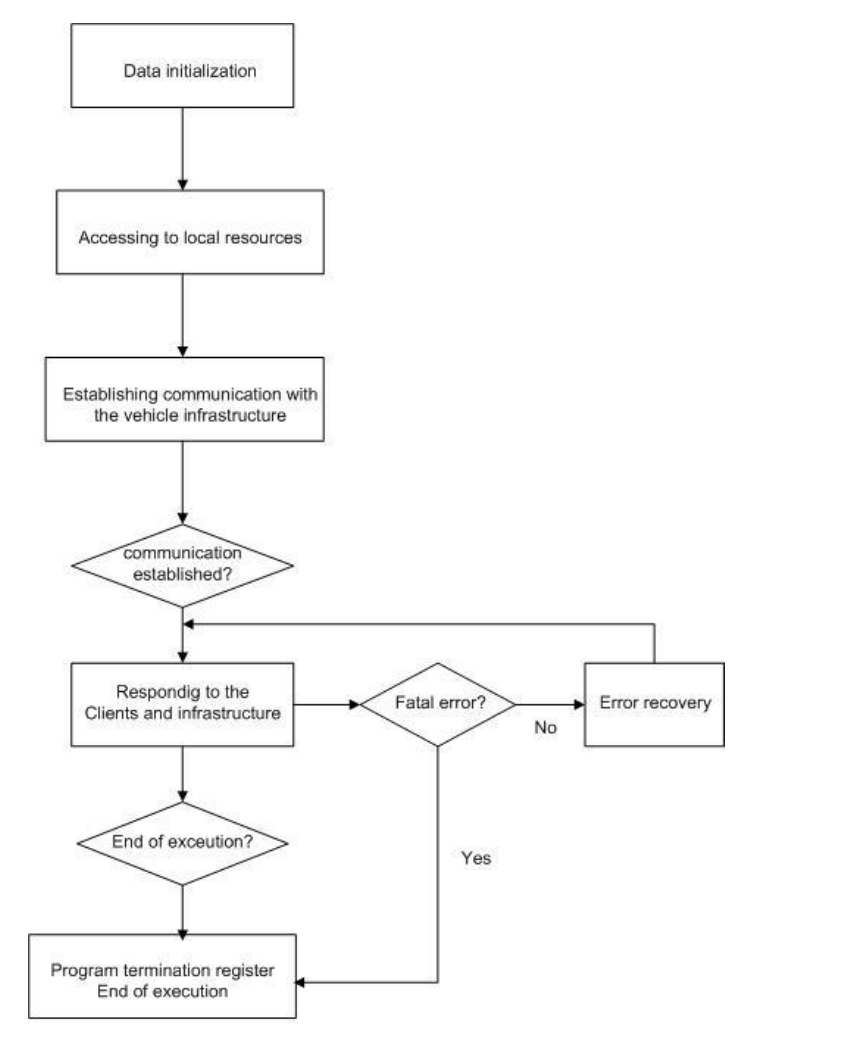
Figure 8. Flow diagram of the information